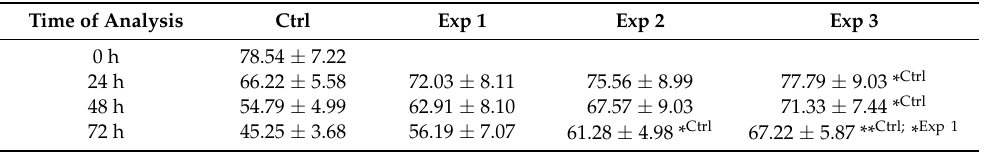
Table 1. Motility of boar spermatozoa (%) exposed to selected semen extenders during different time